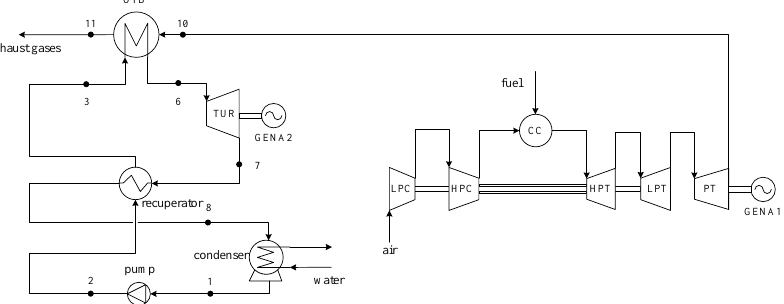
Figure 1. Simplified layout of the power system on the Draugen offshore oil and gas platform; the exhaust gases of one engine feed the organic Rankine cycle module. The two remaining gas turbines are not shown. Once-through boiler: OTB; low pressure compressor: LPC; high pressure compressor: HPC; low pressure turbine: LPT; high pressure turbine: HPT; power turbine: PT. Combustion chamber: CC; Organic Rankine cycle turbine: